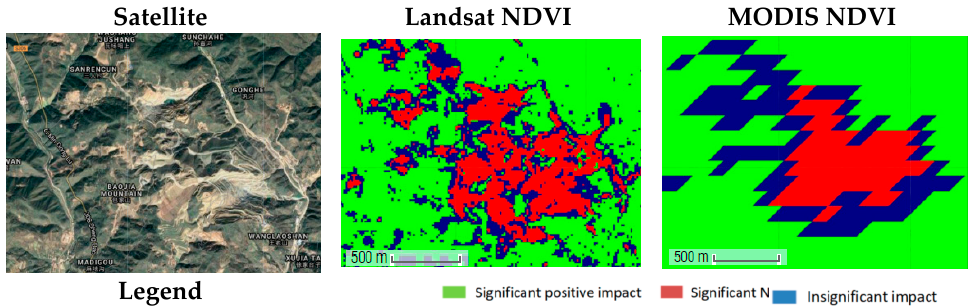
Figure 13. The comparison diagram of significant change in Landsat NDVI and MODIS NDVI (2000–2018).